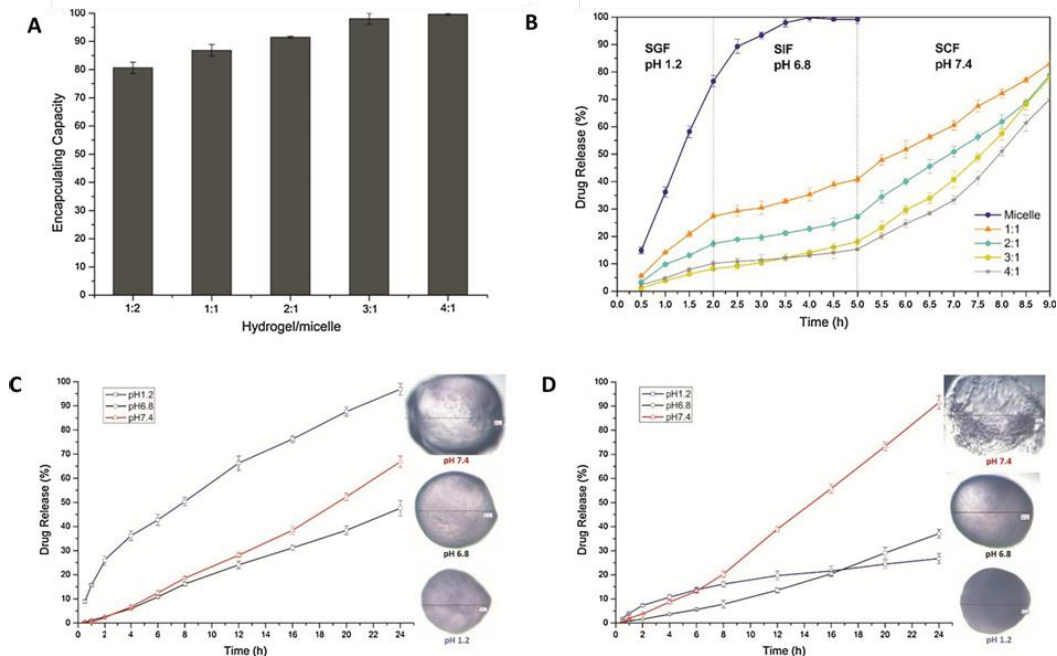
Figure 8. ( A ) The encapsulating capacity of different hydrogel/micelle systems. ( B ) In vitro drug release profiles of micelles and different hydrogel/micelle systems. ( C ) The drug release profiles of hydrogel/micelle = 1:1 and ( D ) hydrogel/micelle = 3:1 systems in simulated gastric fluid (SGF), simulated small intestinal fluid (SIF), and simulated colonic fluid (SCF), individually ( A – D reproduced with permission from [133], copyright Elsevier, 2018).